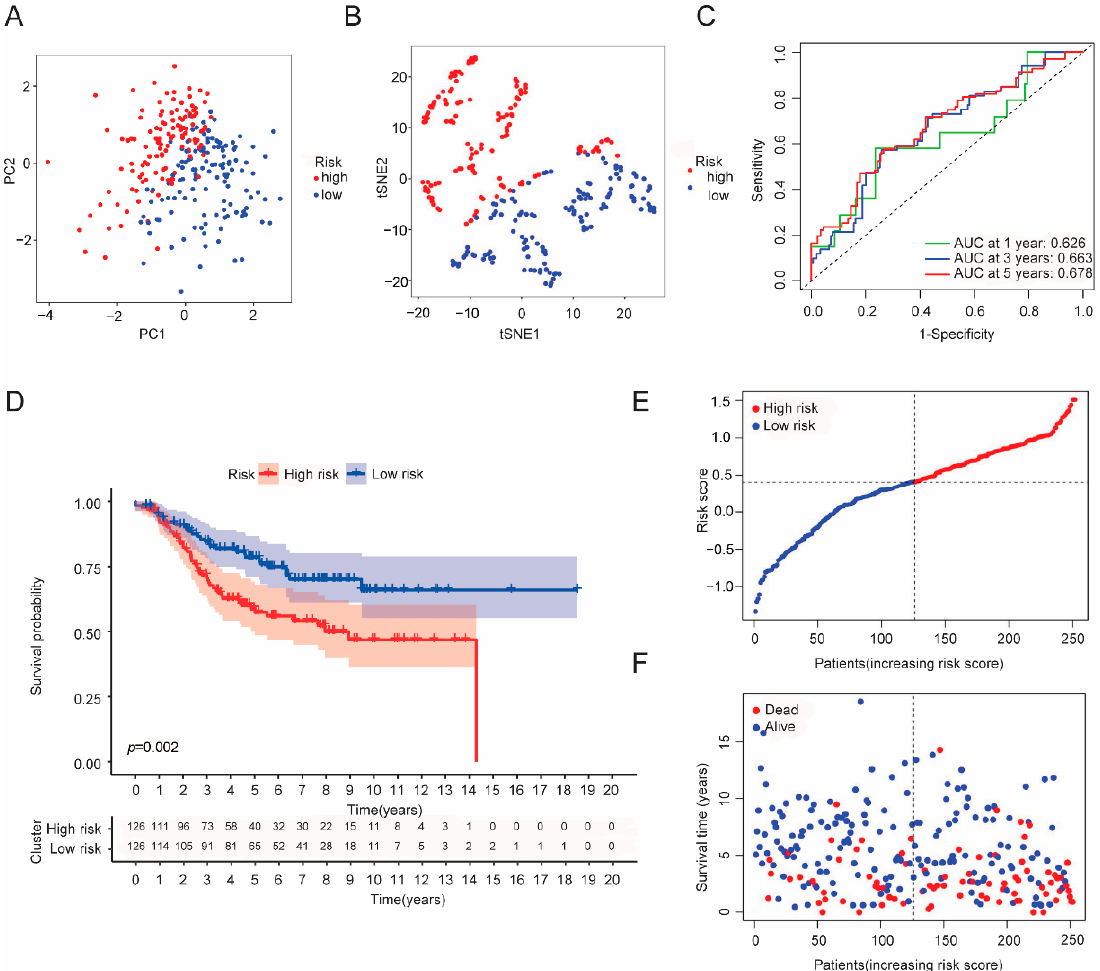
Figure 5. Validation of the risk score model in the validation set (GEO cohort). ( A ) PCA plot for BRCA patients. ( B ) tSNE plot for BRCA patients according to the risk score. ( C ) Time-dependent ROC curve analysis for BRCA patients. ( D ) Comparison of Kaplan–Meier curve analysis between two risk groups. ( E ) Distribution of patients in validation set based on the risk score. ( F ) The survival status distribution for each patient of different risk groups.